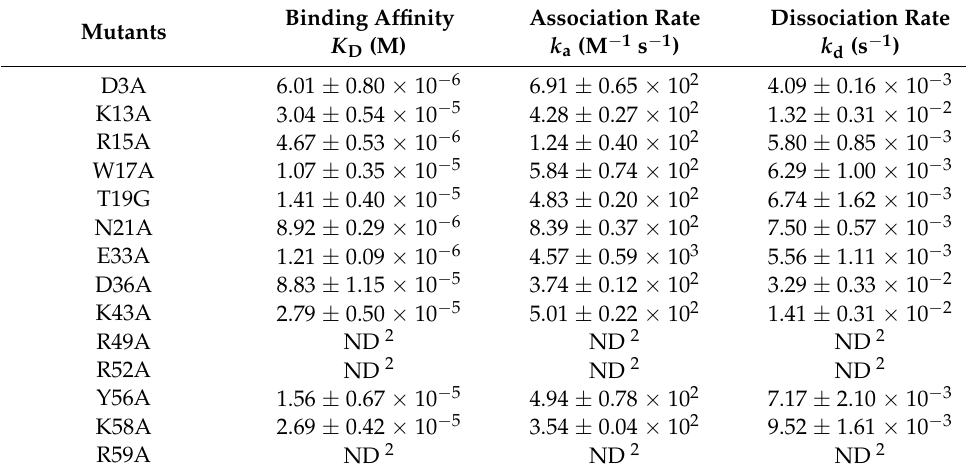
Figure 6. DNA binding surface of Sul7s. ( A ) The two opposite surfaces containing the residues of Sul7s that display large chemical shift perturbation (CSP), colored by electrostatic potential. Blue, positively charged; red, negatively charged; white, neutral. Region I and region II are indicated by ellipses in dashed line, respectively. Three key residues for ssDNA binding, i.e., R49, R52, and R59, are also indicated and labeled. ( B ) The representative conformer of the NMR structure of Sul7s is shown in ribbon in the same orientation as in ( A ). Residues included in the mutation analyses are shown in sticks and labeled. The residues that the mutations led to a severe, a moderate, and little decrease in DNA binding affinity of Sul7s, shown in pink, blue, and yellow, respectively. Table 2. Kinetic parameters of the binding of wild type and mutant Sul7s proteins to S30 as deter- mined by BLI 1